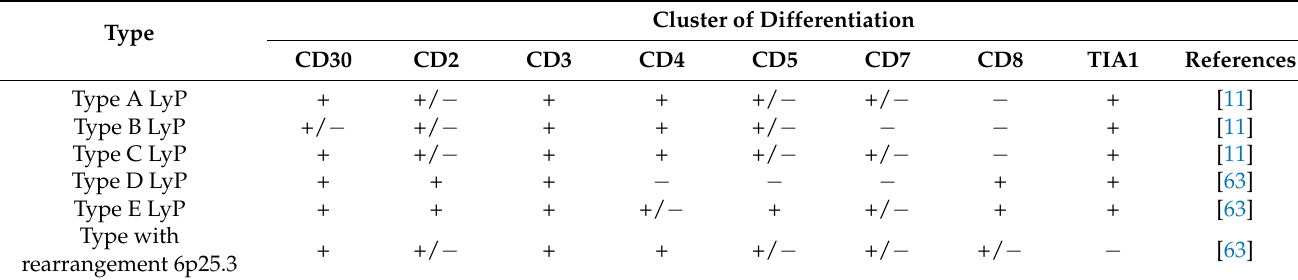
Table 1. Participation of individual CD markers in immunohistochemical analyses of lymphomatoid papulosis